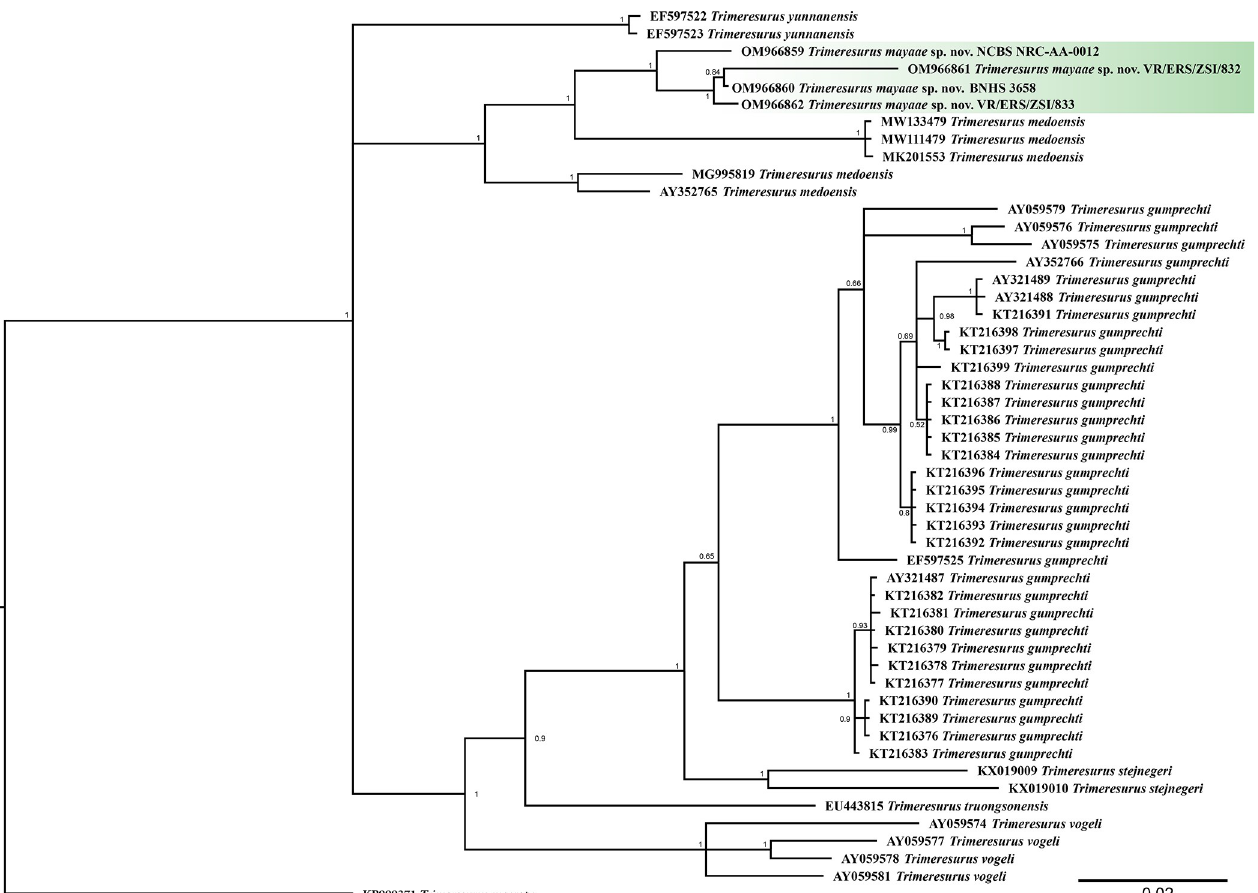
Fig 2. Bayesian inference phylogeny of members of the subgenus Viridovipera . Numbers at notes indicate BI posterior probability. The outgroup has been remove, see S2 Fig for complete tree.